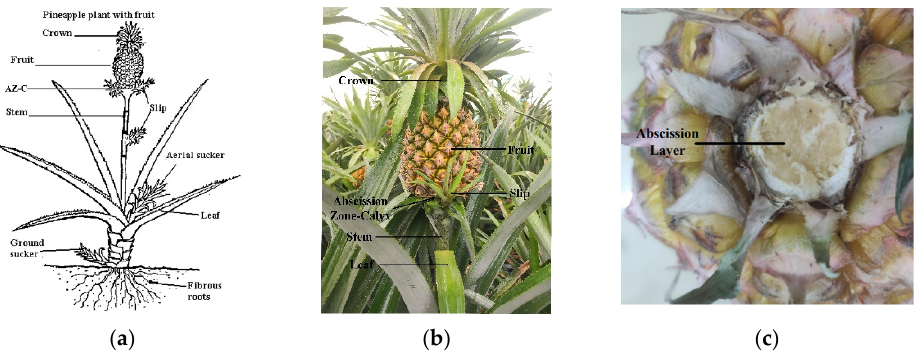
Figure 3. Schematic diagram of pineapple plant structure name. ( a ) Citrus leaf and fruit abscission zones. ( b ) Pineapple plant with fruit. ( c ) Pineapple abscission layer.